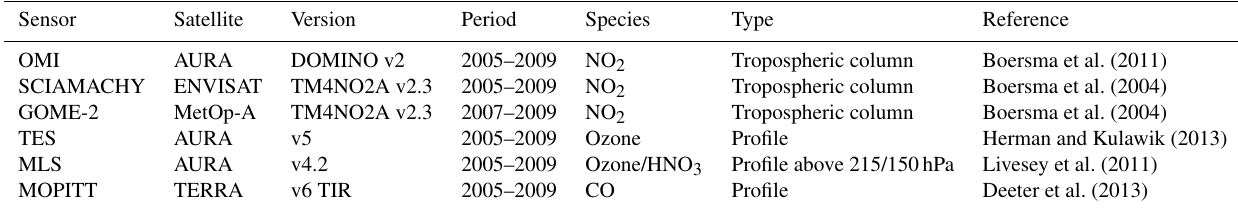
Table 1. Measurements used for data assimilation in the chemical reanalysis. Sensor Satellite Version Period Species Type Reference OMI AURA DOMINO v2 Tropospheric